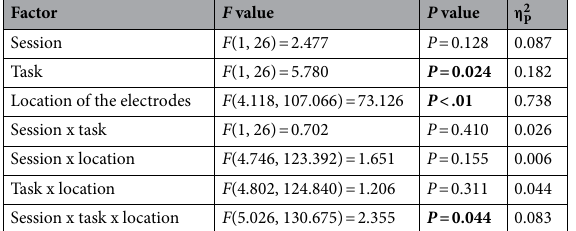
Table 2. The results of repeated measures ANOVA for ERP amplitude parameter. Significant are in bold.